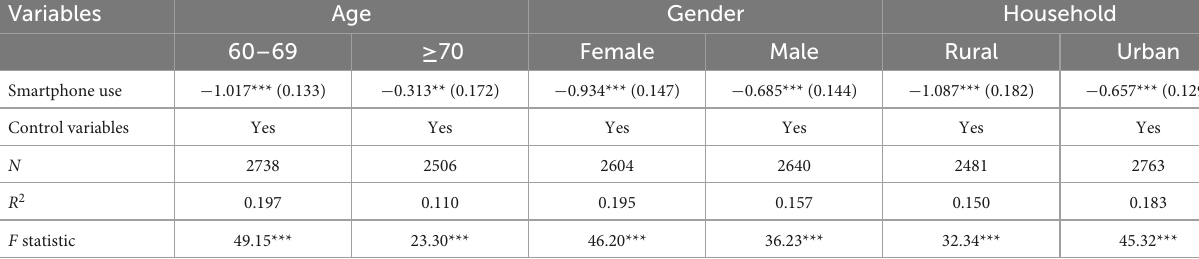
TABLE 3 Heterogeneity analysis of the impact of smartphone use on depression symptoms. Variables